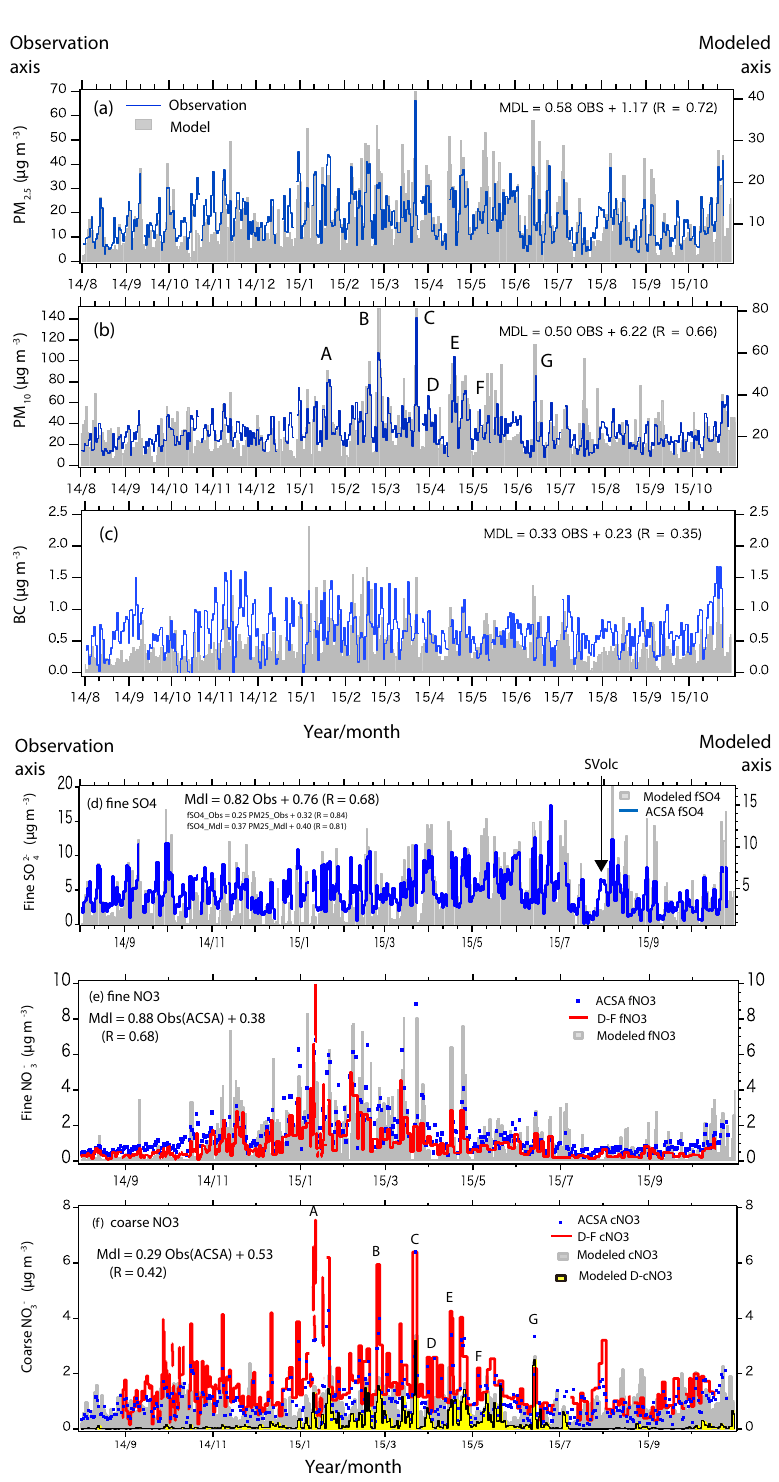
Figure 3. Daily average (a) particulate matter < 2.5µm diameter (PM 2 . 5 ), (b) particulate matter < 10µm diameter (PM 10 ), (c) black carbon (BC), (d) fine SO 2 − , (e) fine NO − , and (f) coarse NO − . The blue line and dots show aerosol chemical speciation analyzer (ACSA) obser- 4 3 3 vations, the red line indicates measurements from the denuder–filter pack (D-F) method, and gray shading indicates the model simulation. D-F data are sampling period averages. Observed data are on the left axis and numerical results are on the right axis, scaled by the regression results (except for panel c ). Symbols A–G in panel (b) indicate major dust events in